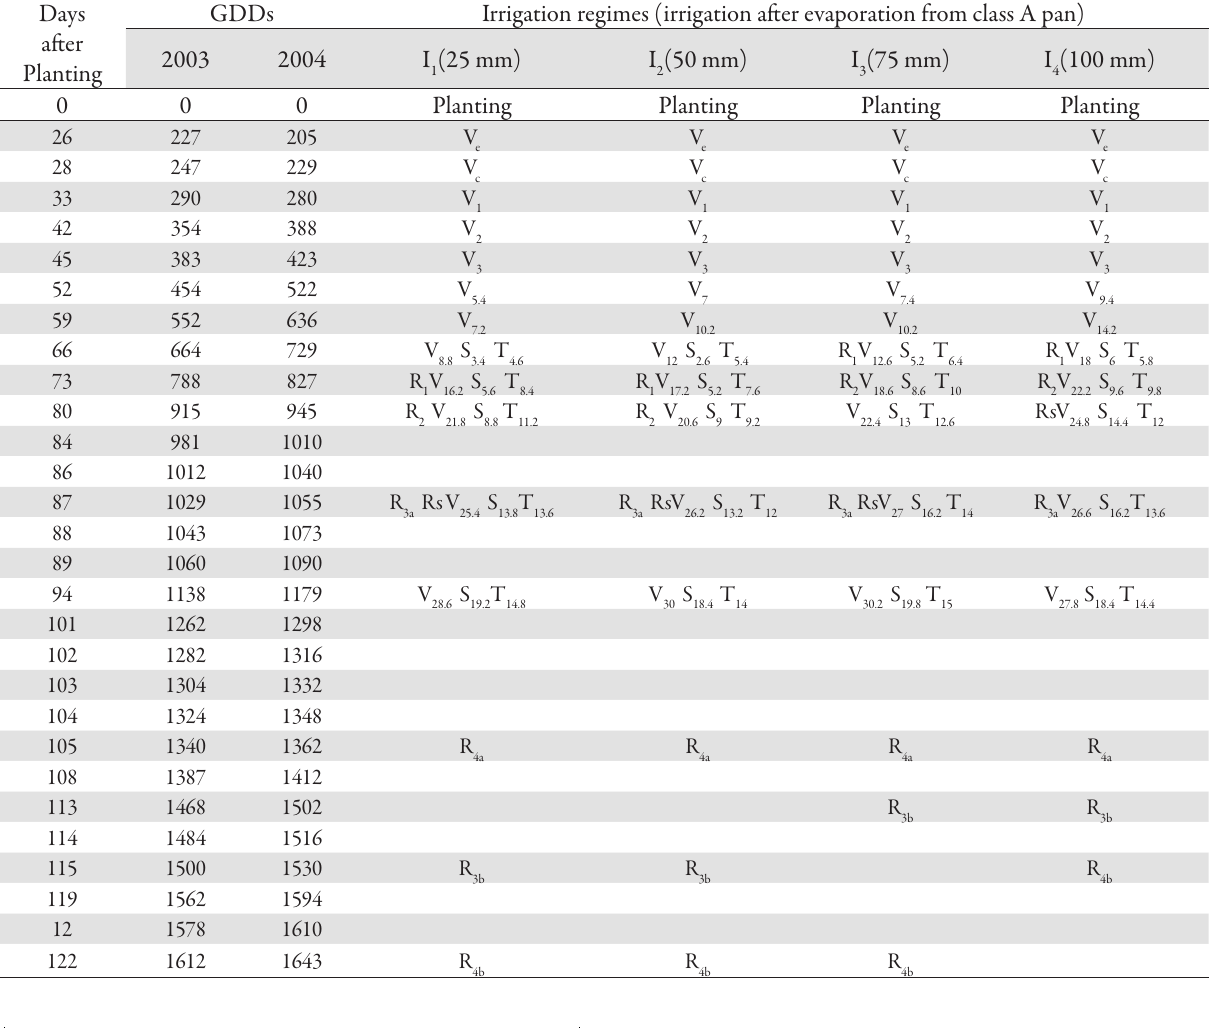
slope of reduction. At last, this slope got zero for second harvest of seed because of ending growth season on this stage. Results showed no differences of the number of leaves and tillers among irrigation levels with means 27.377 and 12.683, respectively. But, plant density had significant (P<0.05) and non-significant effect on the numbers of leaves and tillers. Despite of this significance all levels of plant densities had same numbers of leaves and tillers un- der among plant densities. However, there were significant interaction between irrigation and plant density on the numbers of sub stem (Tab. 4). Results indicated that levels of each factor in other factor had a same trend of the num- bers of sub stem (Tab. 5).